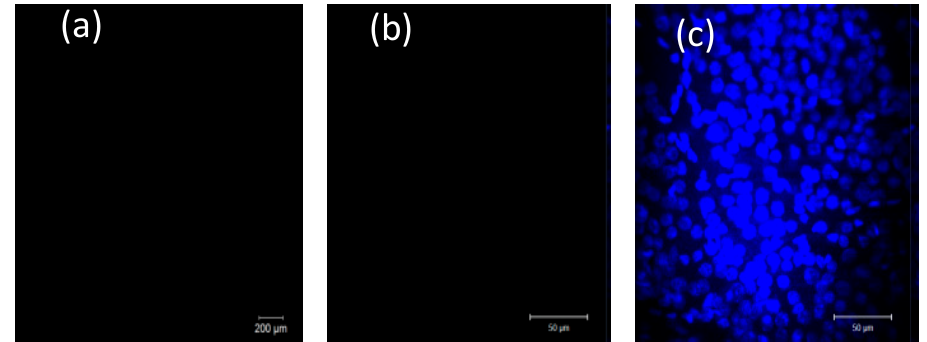
Figure 7. Imaging of retina in control animal experiments where rats received only phosphate buffered saline intravitreally. As expected, no fluorescence can be detected either in vivo (ICON) ( a ) or in the ex vivo retina whole mount preparation ( b ) (red channel for rhodamine 123 detection). ( c ) The retina whole mount, nuclei staining by Hoechst 33342. Scale bars: ( a ) 200 µm; ( b , c ) 50 µm.